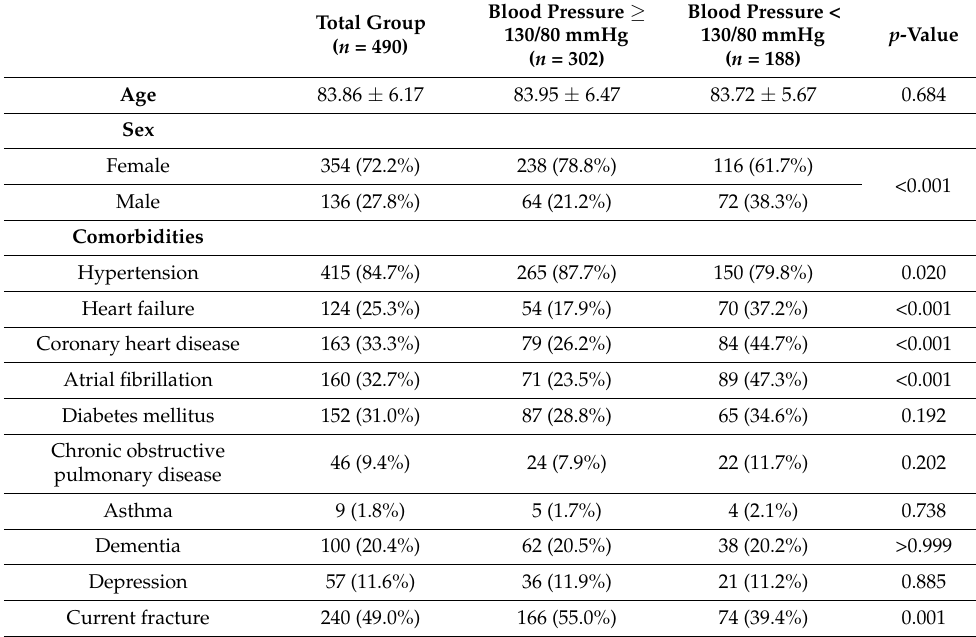
Table 1. Factors associated with hypertensive blood pressure